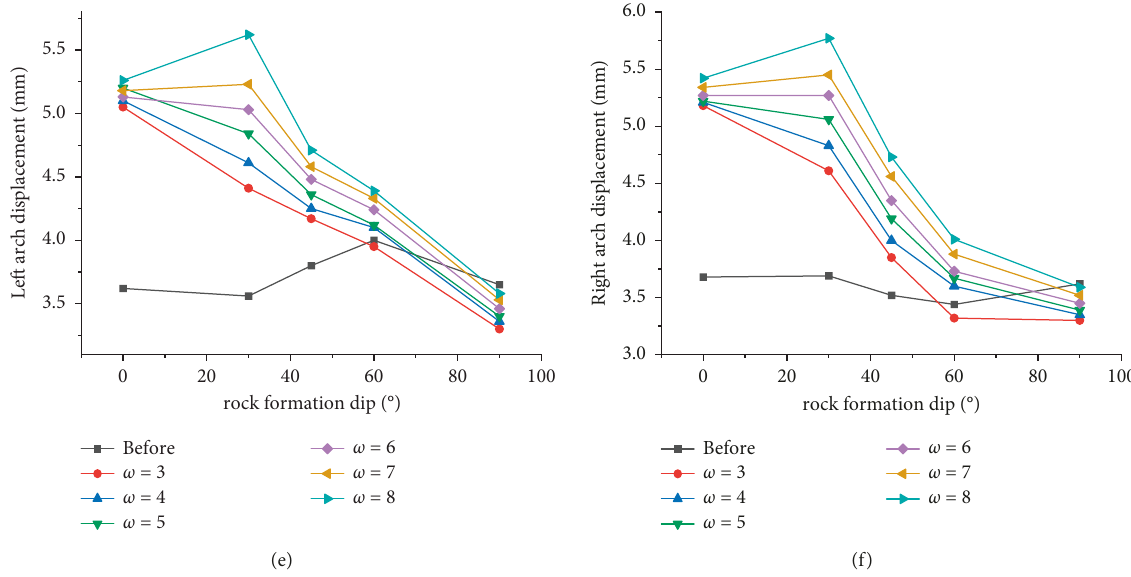
Figure 13: Effect of slope coefficients on the displacement of key points. (a) Simulation values of the vault displacement under different slope coefficients. (b) Simulation values of the arch bottom displacement under different slope coefficients. (c) Simulation values of the dis- placement of the left arch shoulder under different slope coefficients. (d) Simulation values of the displacement of the right arch shoulder under different slope coefficients. (e) Simulation values of the displacement of the left arch foot under different slope coefficients. (f) Simulation values of the displacement of the right arch foot under different slope